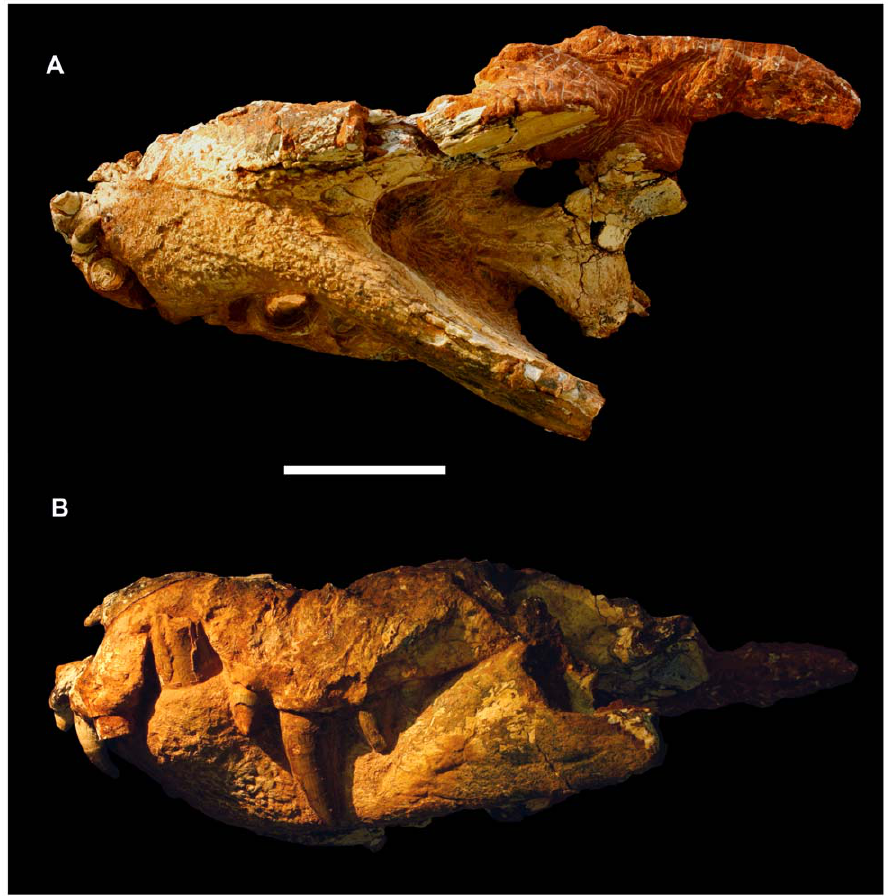
Figure 6. Skull of the referred specimen of Pissarrachampsasera (LPRP/USP 0018). A) ventral; B) lateral (mirrored) views. Scale bar equals 5 cm.